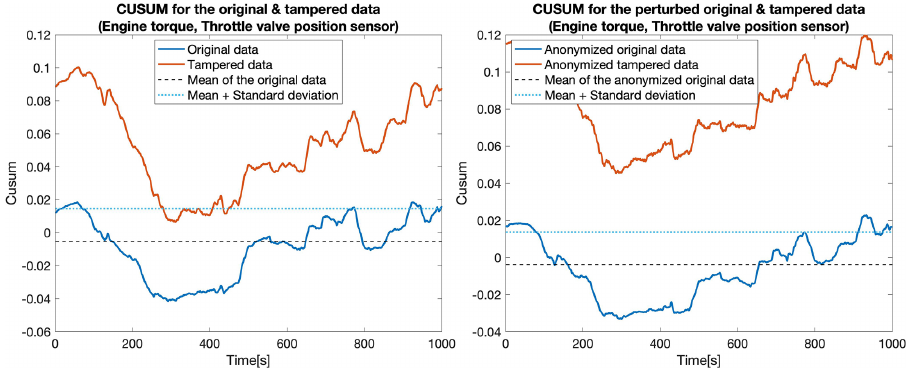
Figure 13. CUSUM for the original data (blue) and tampered data (orange) for sensors: Engine torque and Throttle valve position .